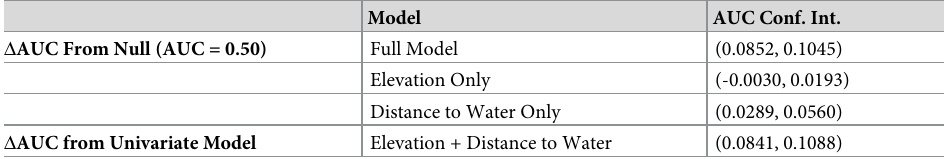
Table 2. Statistical summary comparing model performance.